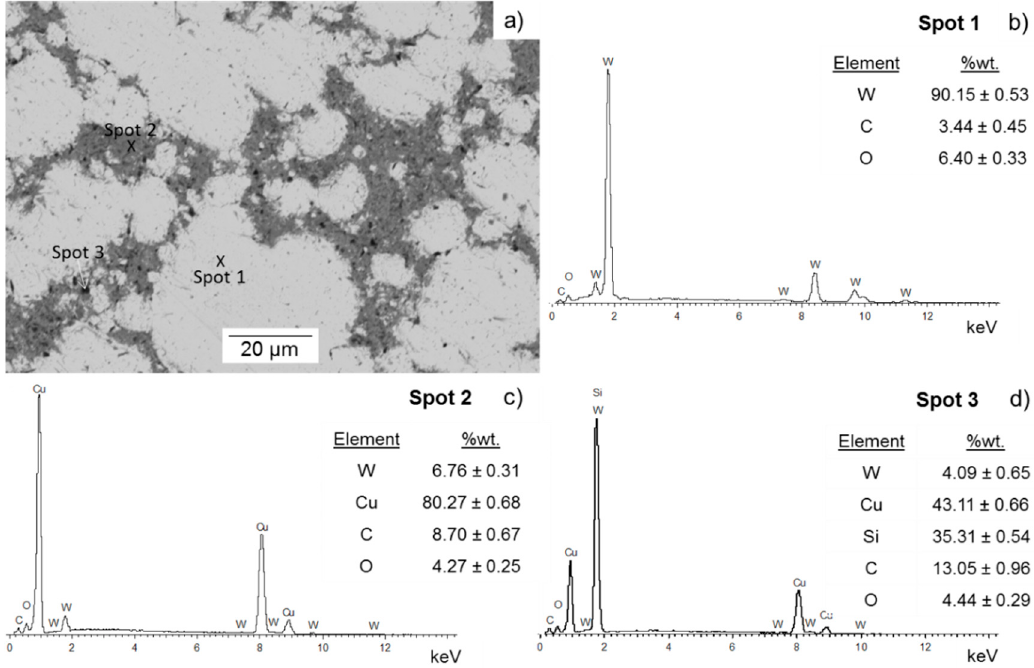
Figure 4. ( a ) Back Scattered Electron-SEM image of 85-W/15-Cu alloy from W bimodal powder 10-W f :90-W c powder produced under 10 s for degasification and 90 s for hot consolidation; ( b ) energy dispersive X-ray spectroscopy (EDS) spectrum in Spot 1 (W phase); ( c ) EDS spectrum in Spot 2 (Cu phase) and ( d ) EDS spectrum in Spot 3 (impurities from metallographic preparation).